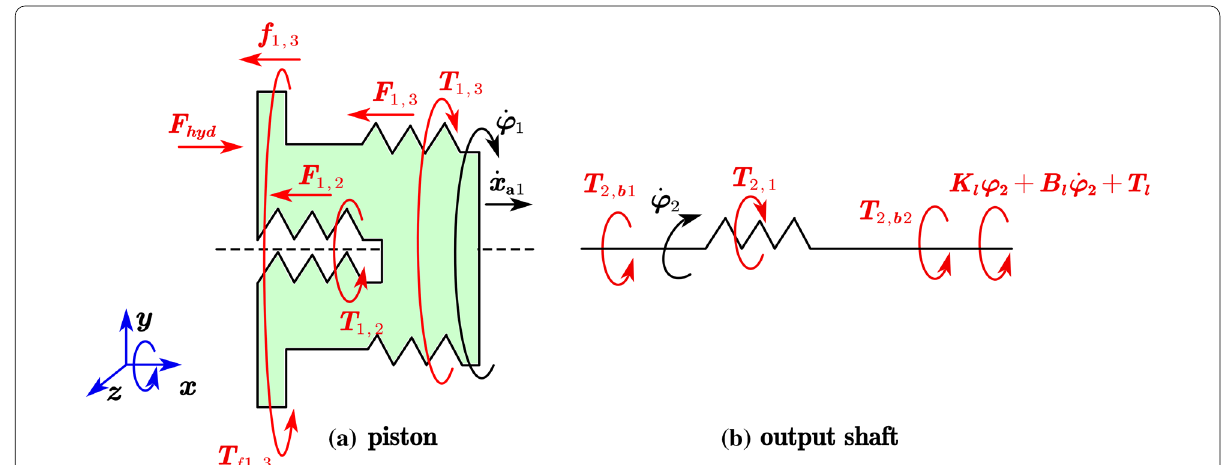
Figure 3 Mechanical analysis of piston and output